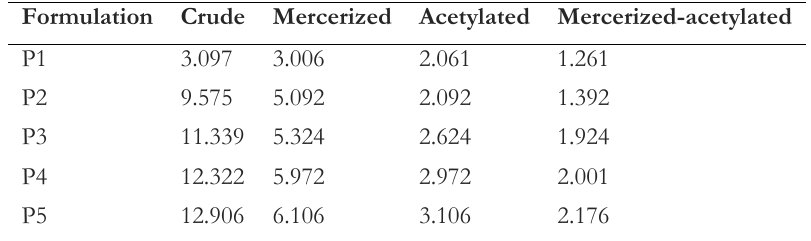
Table 4. Percentage of water absorption of Bamboo fibre polyester composites.